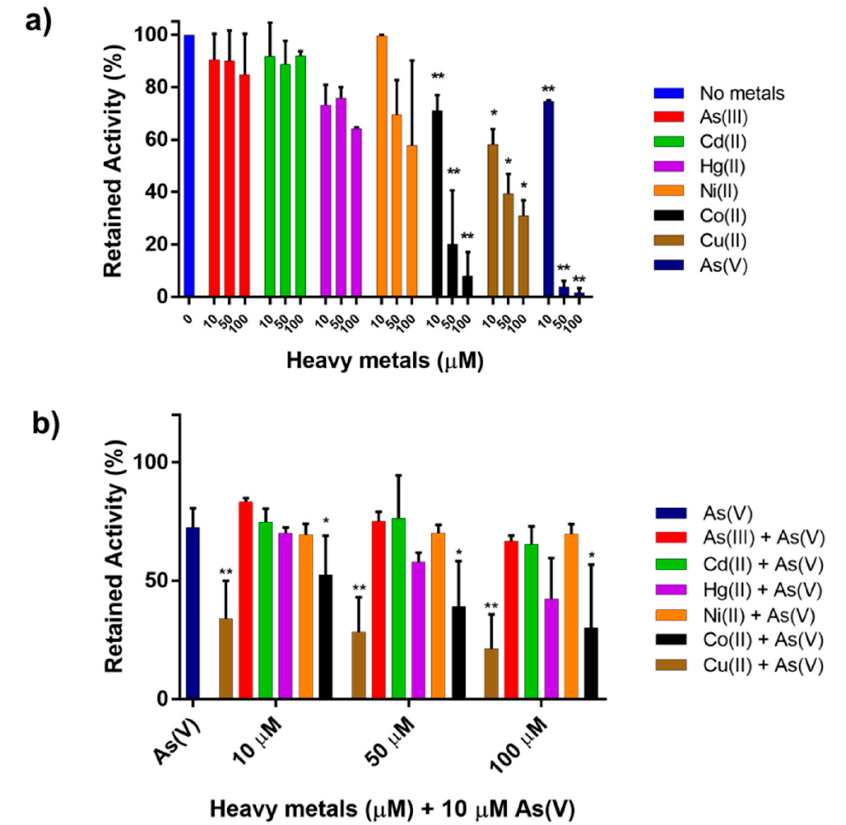
Figure 3. ( a ) Retained activity of Tt ArsC in presence of 10, 50, and 100 µ M of heavy metals; ( b ) Retained activity of Tt ArsC in presence of a fixed concentration of As(V) (10 µ M) and increasing concentrations of other heavy metals (10, 50, and 100 µ M). Heavy metals are reported as follows: As(V) in dark blue, As(III) in red, Cd(II) in green, Hg(II) in purple, Ni(II) in orange, Co(II) in black, and Cu(II) in brown. Statistical analysis was performed through the ordinary one-way ANOVA on GraphPad Prism 7.00; significant differences with respect to ( a ) Tt ArsC activity without metals and ( b ) to Tt ArsC activity in presence of As(V) (10 µ M) are indicated as follows: * p < 0.05, ** p < 0.01.